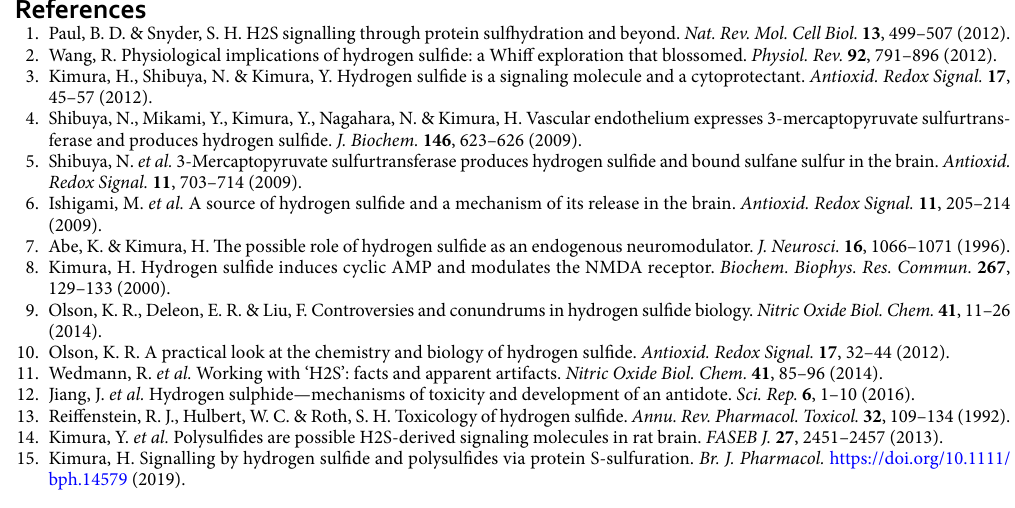
Figure 5. NaHS inhibits Kv2.1 and augments action potential firing in rat hippocampal neurons. ( A ) Families of currents evoked in a rat hippocampal neuron before and during exposure to NaHS (200 μM). Currents were evoked by step-depolarizations, applied up to + 60 mV in 10 mV increments from a holding potential of − 70 mV. Scale bars apply to both families of currents. ( B ) Mean (± s.e.m.) current–density versus voltage relationships obtained in 8 cells before (solid circles) and during (open circles) exposure to NaHS (200 μM). ( C ) Left, example currents evoked in the same neuron before (control) and during exposure to NaHS (200 μM), then during a subsequent exposure to DTT (1 mM) following washout of NaHS. Right, bar graph showing normalised mean (± s.e.m.) effect of NaHS and recovery of current amplitude by DTT. (**Indicates P < 0.01 with the number of cells tested in parentheses). ( D ) Left, example currents evoked in the same neuron immediately after obtaining the whole-cell configuration, after 10 min dialysis with an anti-Kv2.1 antibody, and then during a subsequent exposure to NaHS (100 μM), as indicated. Right, bar graph showing normalised mean (± s.e.m.) effect of the anti-Kv2.1 antibody, and the effects of NaHS following a minimum of 10 min dialysis in these cells. (n.s. indicates P > 0.05 with the number of cells employed indicated in parentheses). ( E ) Example voltage responses evoked by square wave depolarizing current injections (upper traces 50 pA, lower traces 150 pA) in hippocampal neurones perfused in the absence (left hand traces) or presence (right hand traces) of NaHS (200 μM). Scale bars apply to all traces. ( F ) Mean (± s.e.m.) number of evoked action potentials measured in response to 500 ms depolarizing current injections of varying amplitude. Action potentials were measured in the absence (solid circles) or presence (open circles) of 200 μM NaHS (***indicates P < 0.005, n = 6 for all current